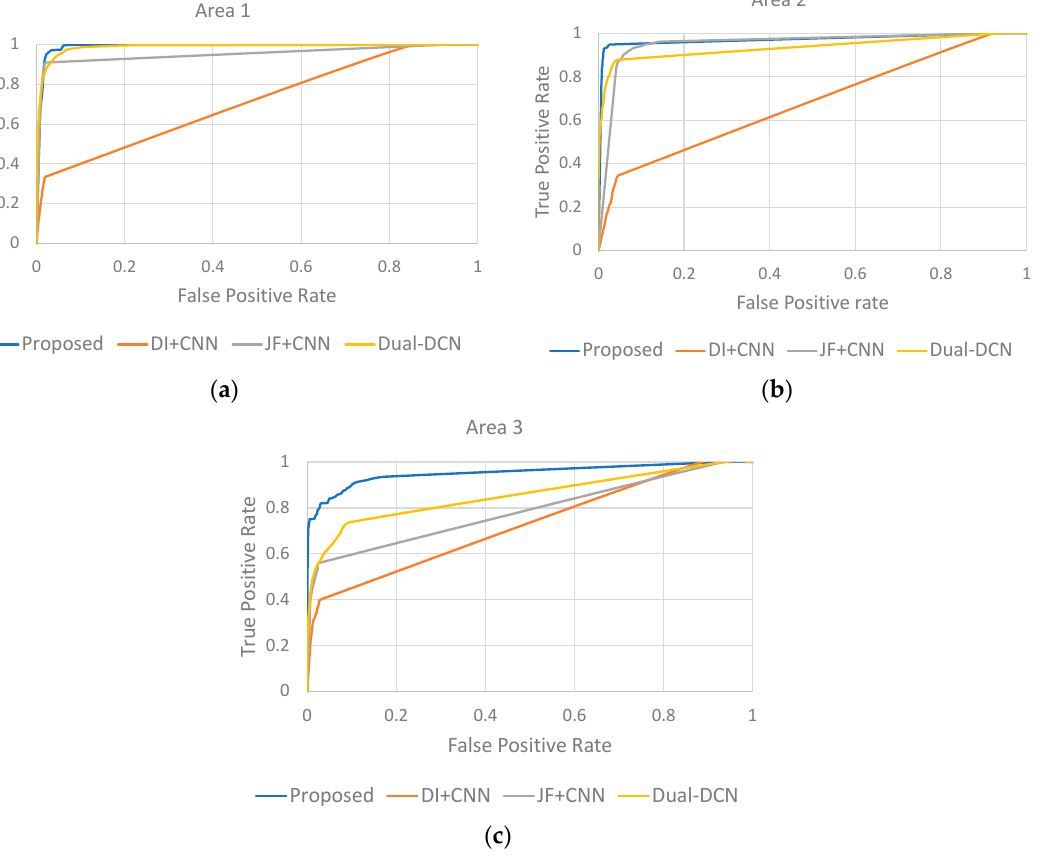
Figure 8. Receiver operating characteristic (ROC) for ( a ) Area 1, ( b ) Area 2, and ( c ) Area 3. Table 2. Quantitative assessment of the existing and proposed